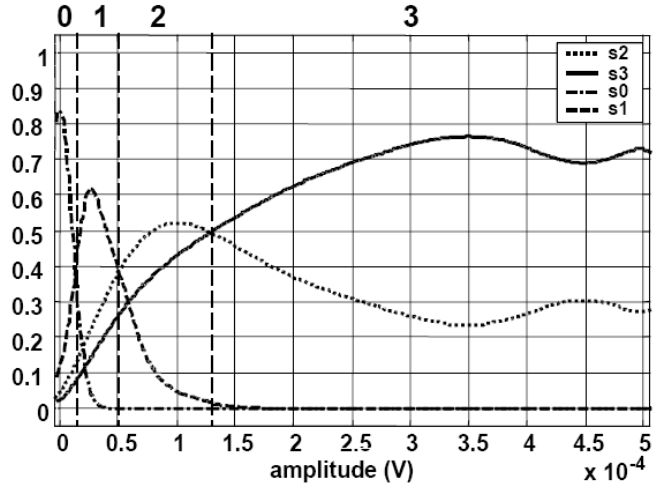
Figure 10. Probability functions P(si|x) and decision thresholds (vertical dotted lines). The thresholds define the regions from 0 to 3, labeled on the